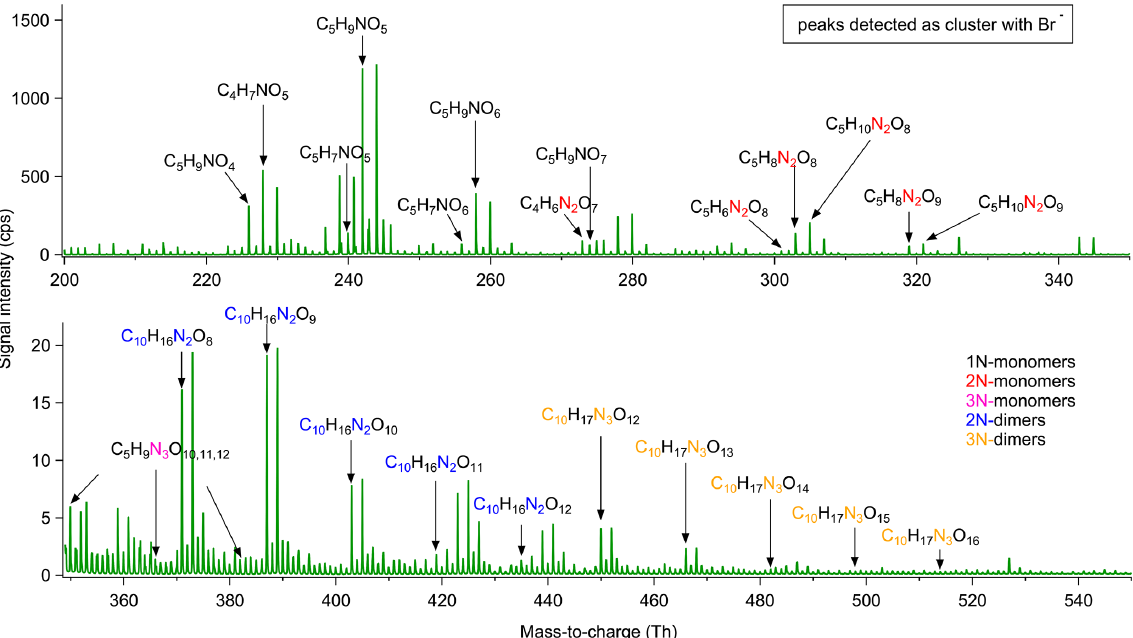
Figure 2. Averaged mass spectra for isoprene-NO 3 experiment on 8 August 2018. Molecular formulas were determined according to the accurate mass data provided by